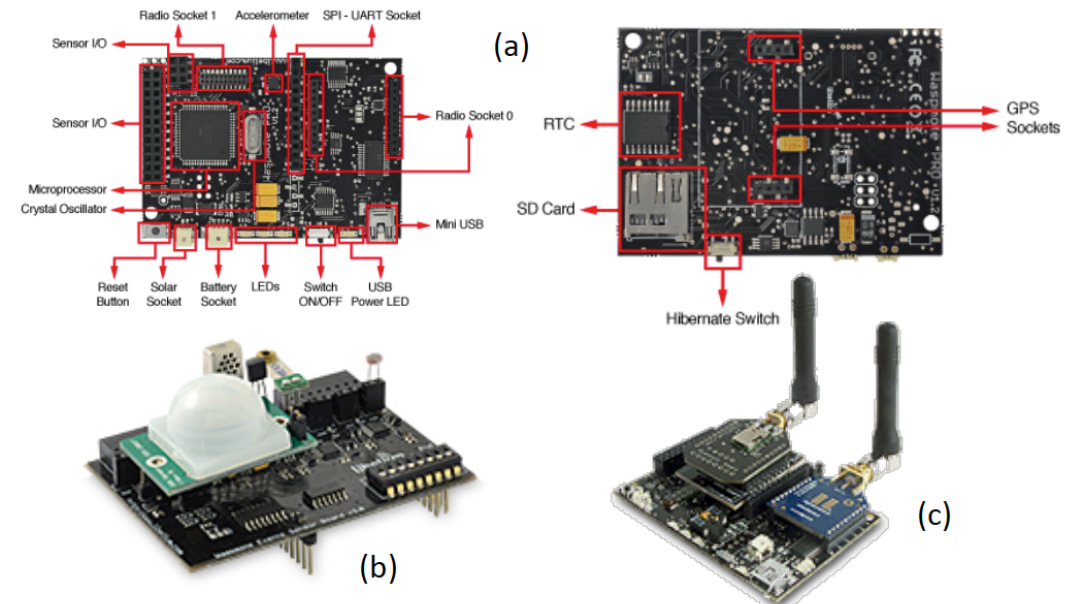
Figure 5. Components of a Libelium sensor device (extracted from [47]): ( a ) Top (left) and bottom (right) view of a waspmote; ( b ) events sensor board; and ( c ) expansion radio